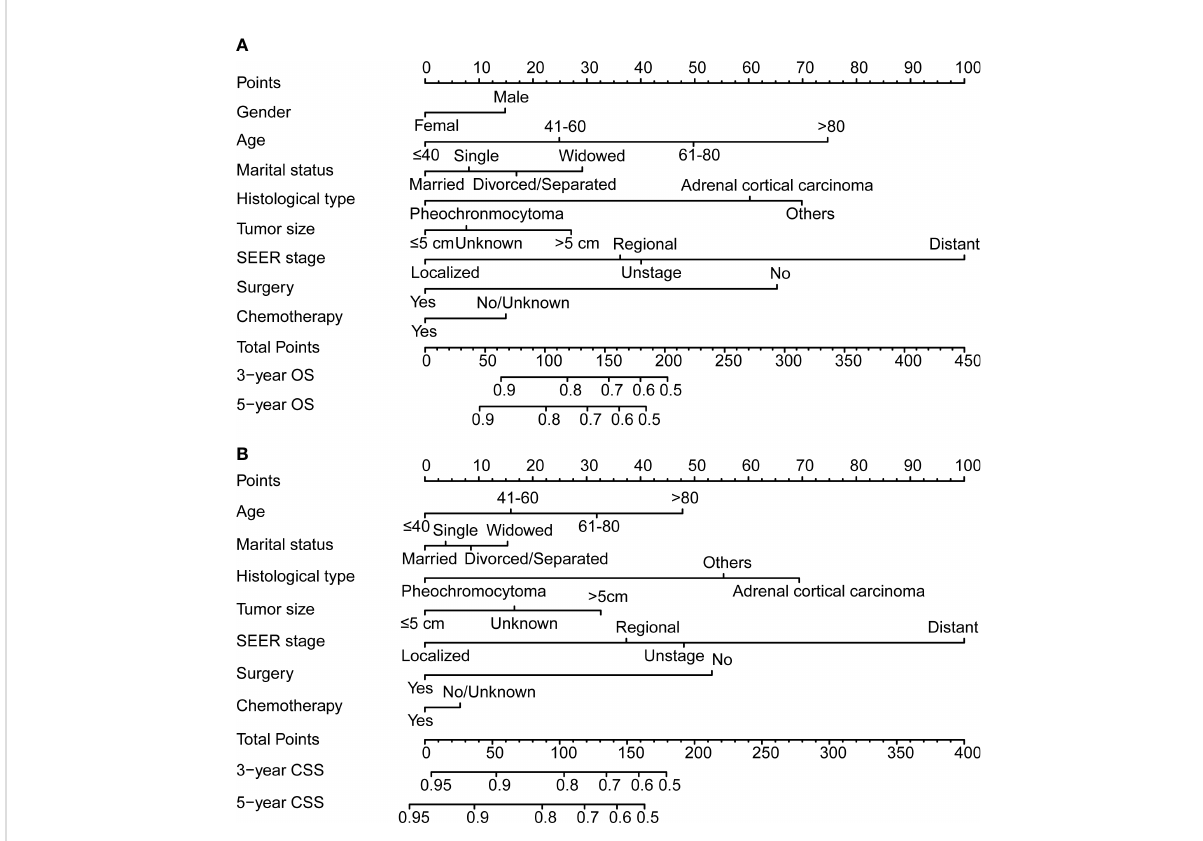
FIGURE 2 The 3- and 5-year nomogram model for overall survival (OS; A ) and cancer-speci fi c survival (CSS; B ) for patients with malignant adrenal